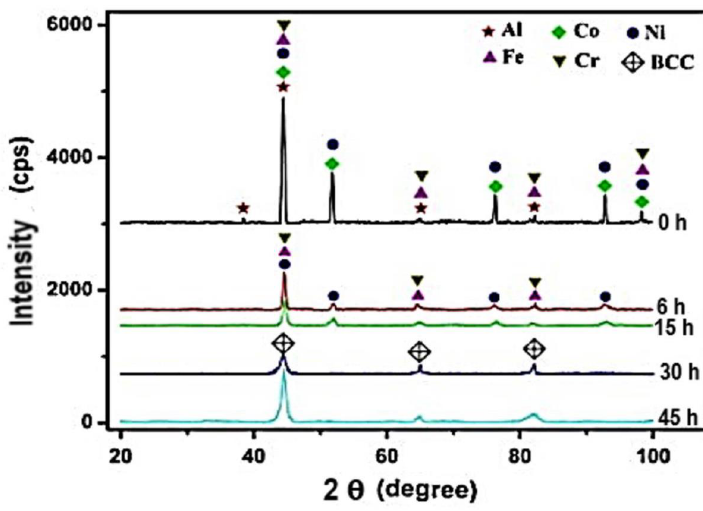
Figure 3. XRD pattern of FeNiCrCo 0.3 Al 0.7 with different milling times [114]. Other elements such as Cr and Fe dissolved into solution as the milling time